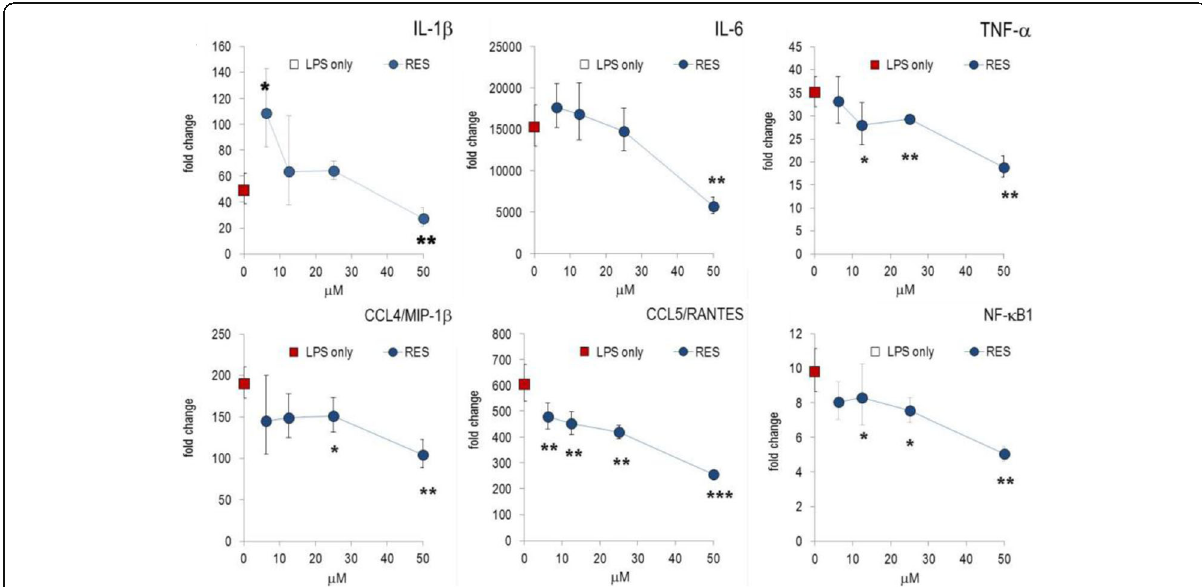
Fig. 2 RES modified gene expression in LPS-stimulated RAW264.7 cells. Cells were incubated with RES, and stimulated with 1 μ g/mL LPS and cultured for 4 h. Gene expression was quantified by RT-PCR and the data expressed as fold change compared to levels observed in unstimulated cells. Results are shown as mean of triplicates (± errors) (see reference [11]). ‘ LPS alone ’ : indicates the value obtained from LPS-stimulated cells (without substance) and is indicated on the y-axis. * p < 0.05, ** p < 0.01, *** p < 0.001 (versus LPS-stimulated